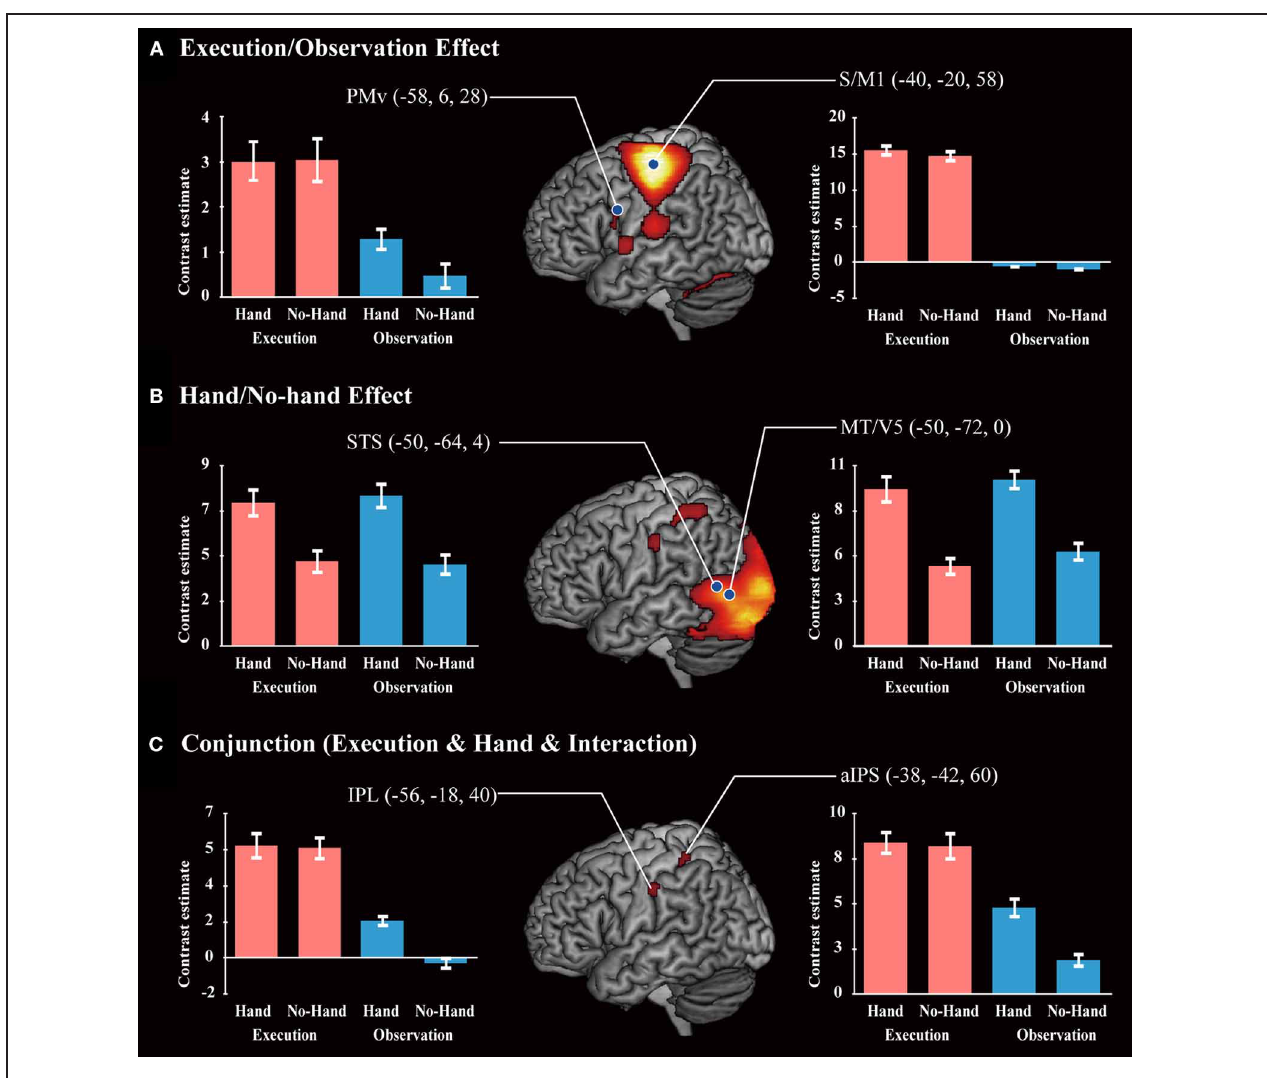
(Execution > Observation) × (Hand > No-hand)]. All results were thresholded at p < 0 . 05 (FWE). Red bars and blue bars show the data for the execution and observation conditions, respectively. Blue dots on the brain images indicate the locations of the ROIs for DCM